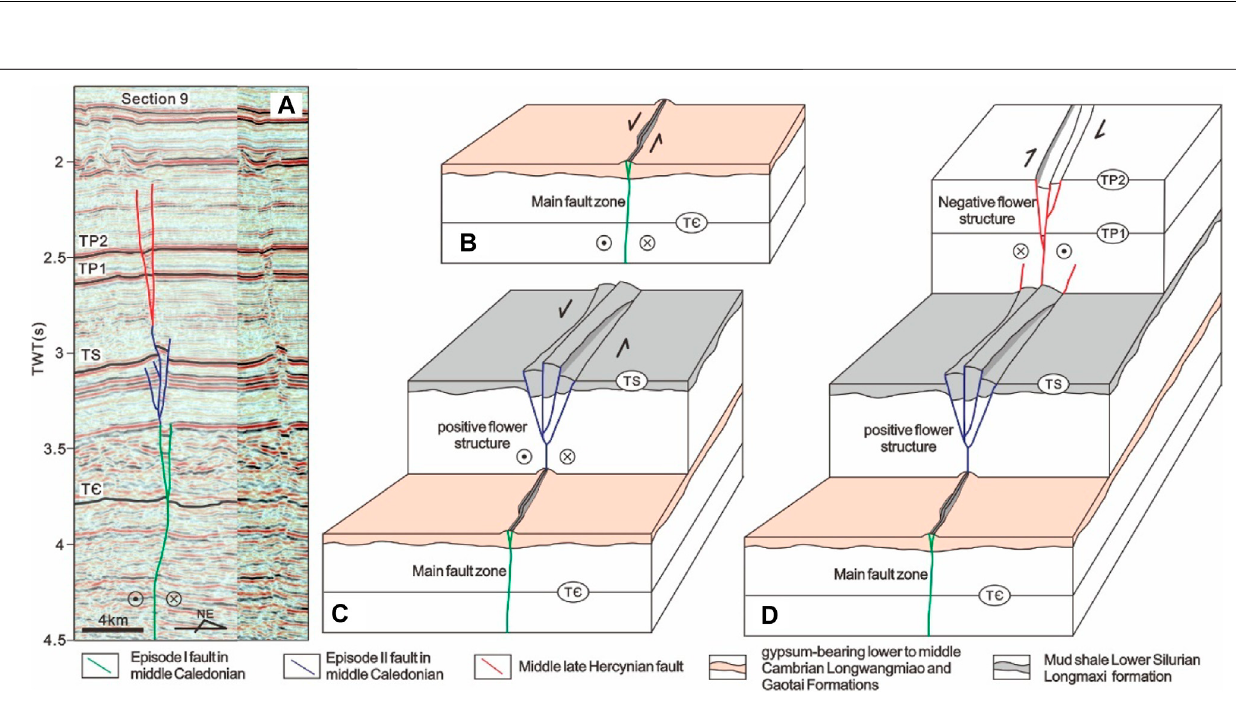
Frontiers in Earth Science |